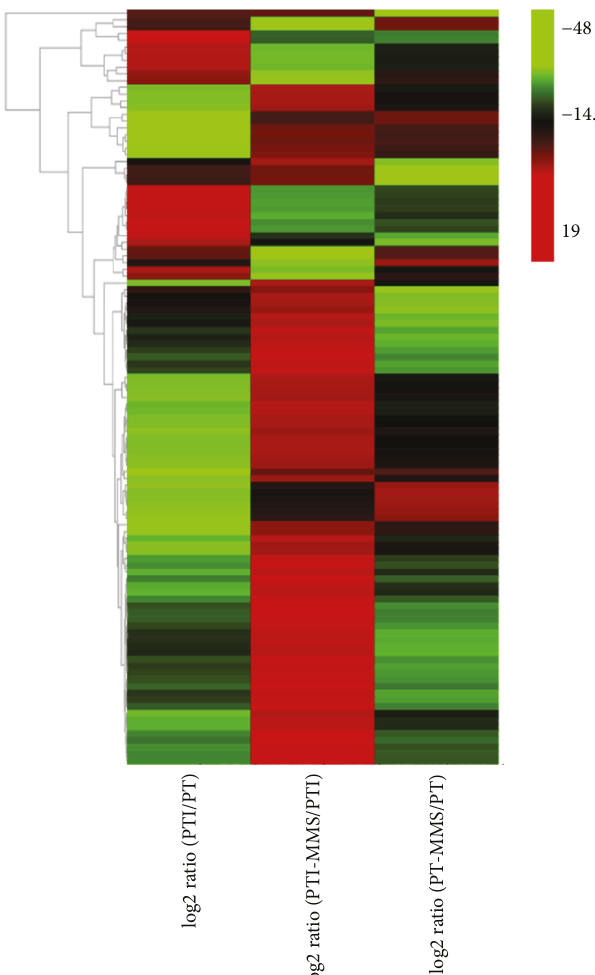
Figure 3: The heatmap of 112 PaWB-related lncRNAs in di ff erent